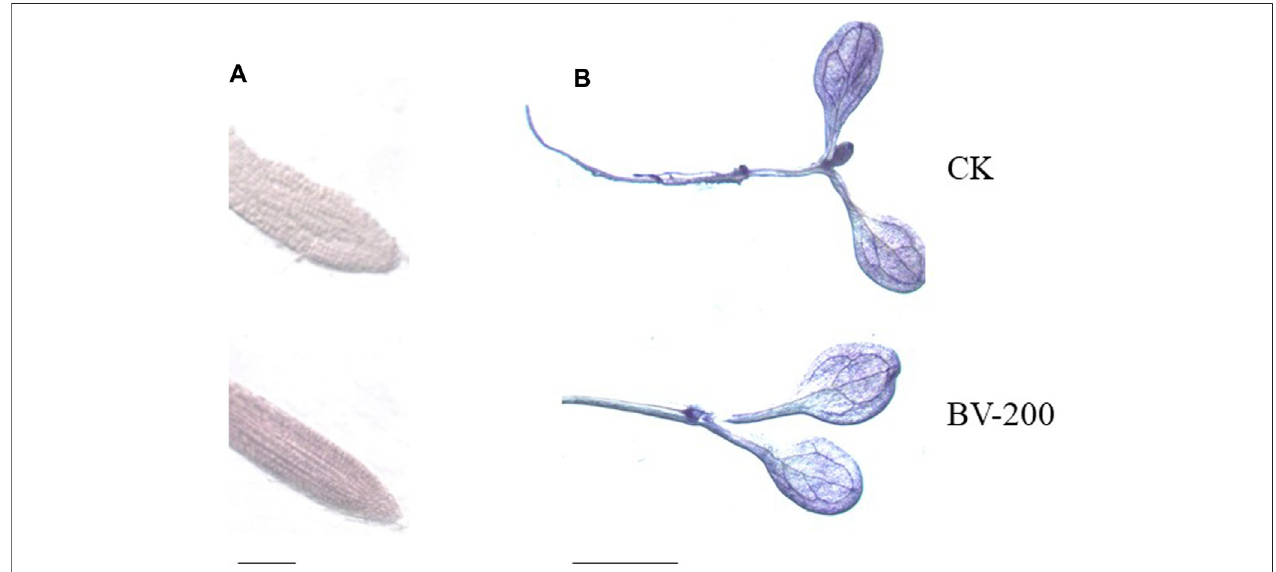
FIGURE 7 | Effect of BV nanomaterial treatment on Arabidopsis tissue staining. (A) TTC staining, scale bar (cid:2) 5 mm. (B) NBT staining, scale bar (cid:2) 2 mm. CK, the control without BV nanomaterials. BV-200, 200 μ g ml − 1 BV treatment. N (cid:2) 6.